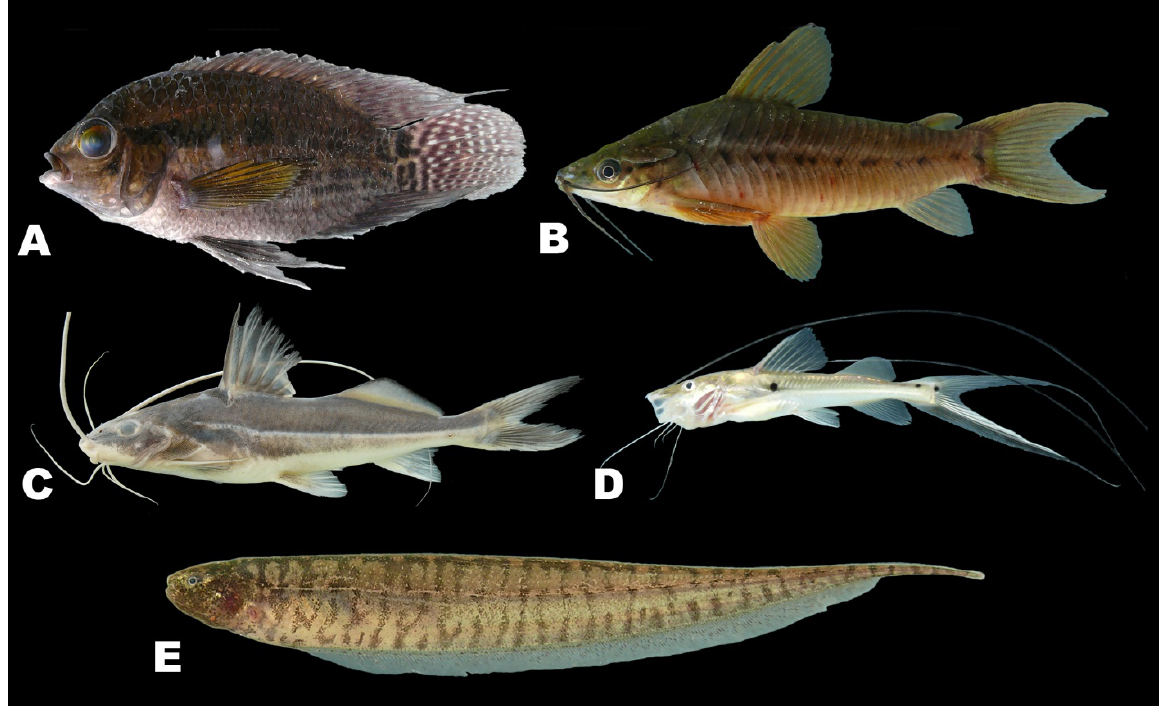
Figure 7. Examples of species collected only in the Alto Purús. (A) Cichlasoma boliviense (79 mm). (B) Dianema longibarbis (73 mm). (C) Pimelodus sp. 2 (112 mm). (D)